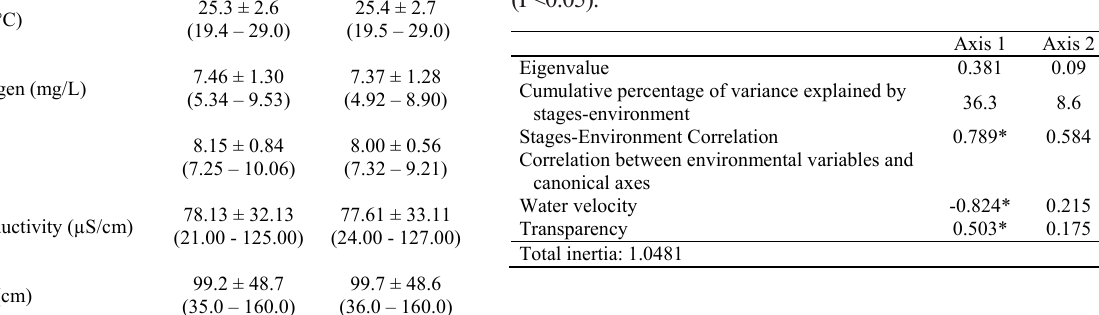
Table 3. Results of the canonical correlation analysis (CCA) performed with the abundance of eggs and larval stage and the environmental variables observed in different sampling sites of the Peixe River, upper Uruguay River, between Octo- ber 2011 and March 2012. *Values with statistical significance